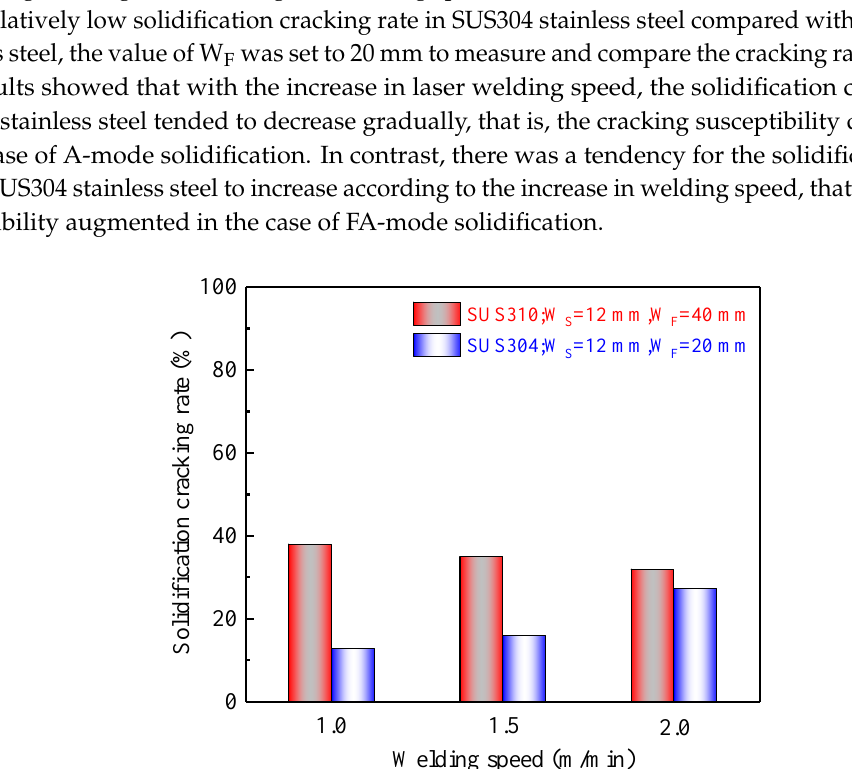
Figure 13. OM image of the microstructure of the cross-section of the weld joint. ( a ) OM image in SUS310 at the welding speed of 1.0 m/min; ( b ) OM image in SUS310 at the welding speed of 2.0 m/min;